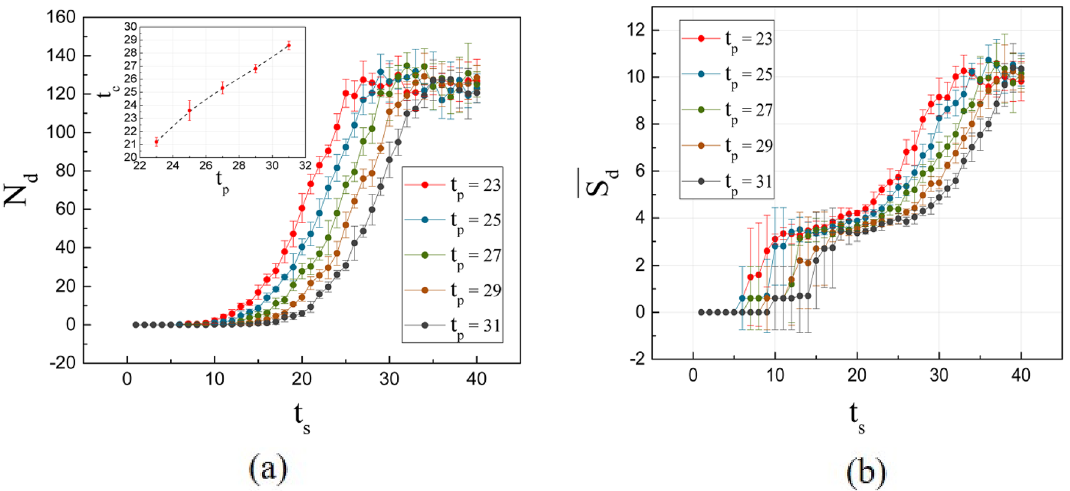
Figure 7. ( a ) Number of domains as a function of time for different values of t p in Monte Carlo simulations. Inset: t c as a function of t p , obtained from these trends. ( b ) Average domain size as a function of time for different values of t p